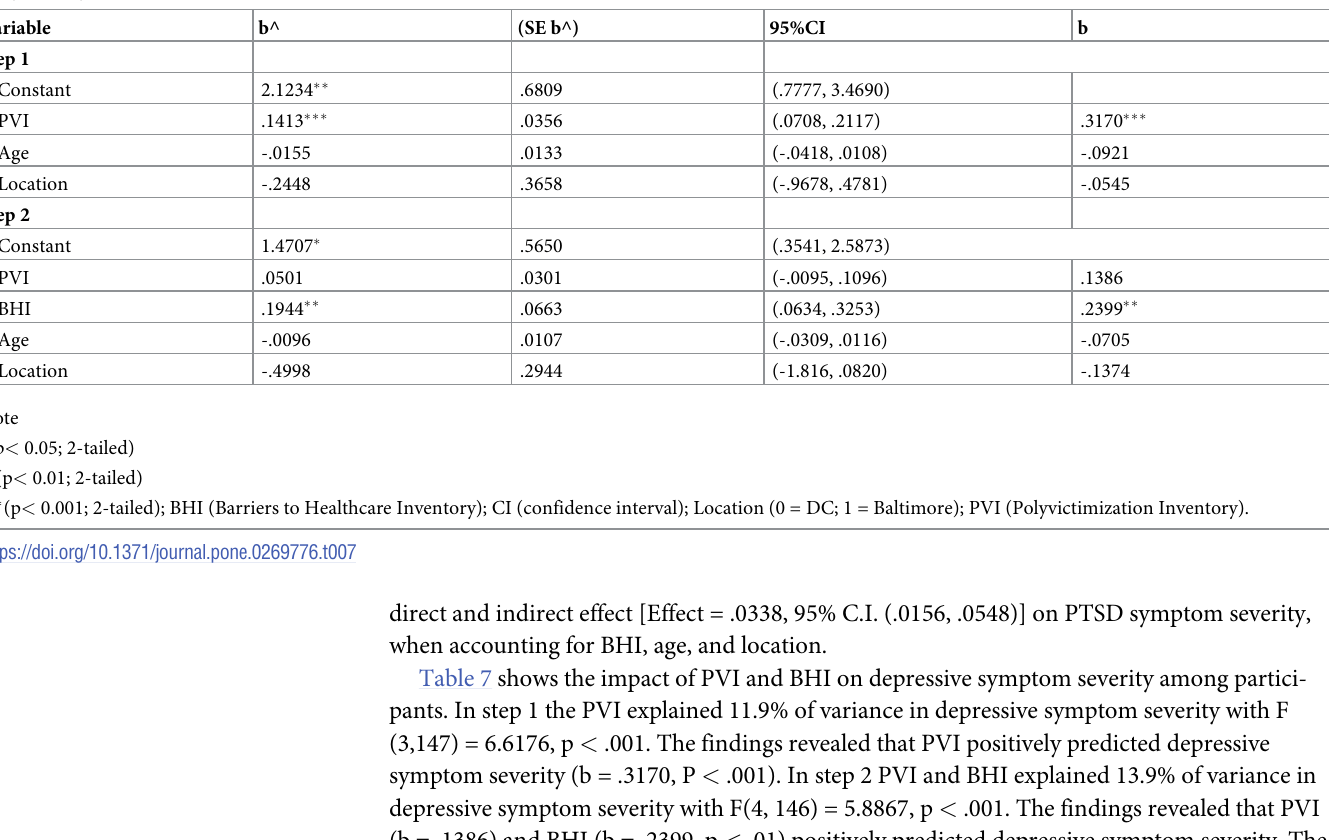
Table 7. Regression analysis for mediation of barriers to healthcare access between polyvictimization and depressive symptom severity among the quantitative sam- ple (N =